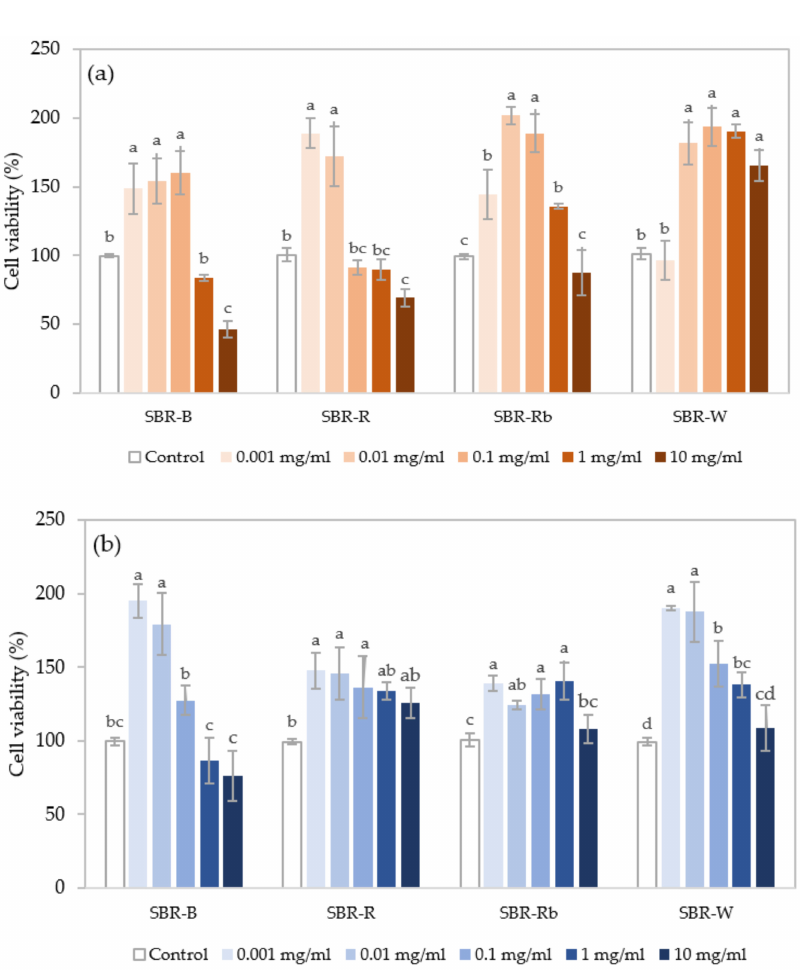
Figure 6. Cell viability effects of ( a ) 50% ( v / v ) ethanolic extracts and ( b ) hot water extracts prepared from different solid-based residues (SBRs) of C. militaris on fibroblast cell lines (NIH/3T3) at different concentrations (0.001–10 mg/mL). Values compared for the same SBR with different superscript letters are significantly different based on Tukey’s test ( p <